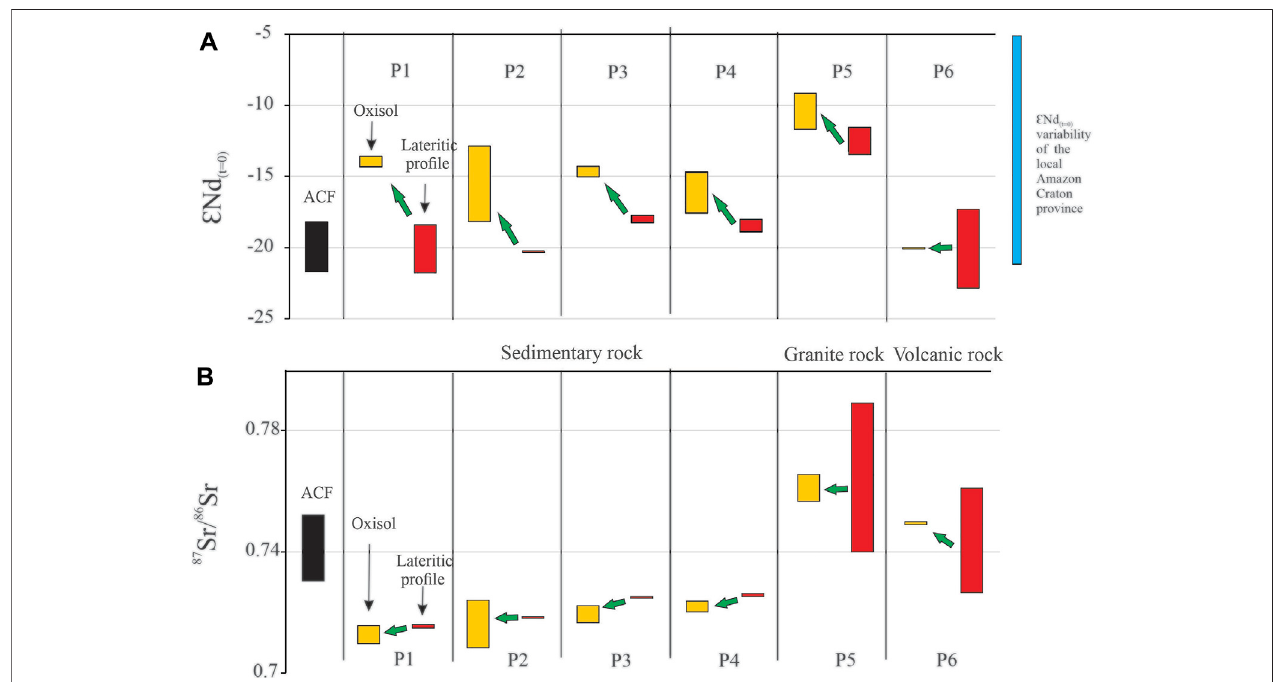
FIGURE9| Plotof Ɛ Nd (t=0) and 86 Sr/ 87 Srratioscomparingthevariabilities(maximumandminimumvalues)betweenthemottledhorizonandthelateriticduricrustin redrectanglerelativetotheOxisolinorangerectangleinpro fi les1to6(P1toP6). Ɛ Nd (t=0 parentrockvariabilitiesfrompro fi les1,2,and3inblackrectangle. (A) Pro fi les1 to3havesimilarparentrock,mottledhorizon,andlateriticduricrustradiogenic Ɛ Nd (t=0) ,andthereisanincreaseintheradiogenic Ɛ Nd (t=0) totheOxisolsexceptinP6. (B) Pro fi les 1 to 3 have decreased radiogenic 86 Sr/ 87 Sr from the parent rock (AFC) to the Oxisol and pro fi le 4 from the mottled horizon and lateritic duricrust to the Oxisol. Pro fi les 5 and 6 have less variabilities in the Oxisol relative to the mottled horizon and lateritic duricrust.